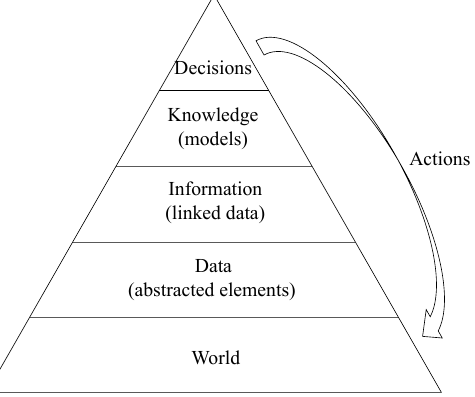
Figure 5. The “knowledge pyramid” (adapted from [73]). Actions affect the “World”